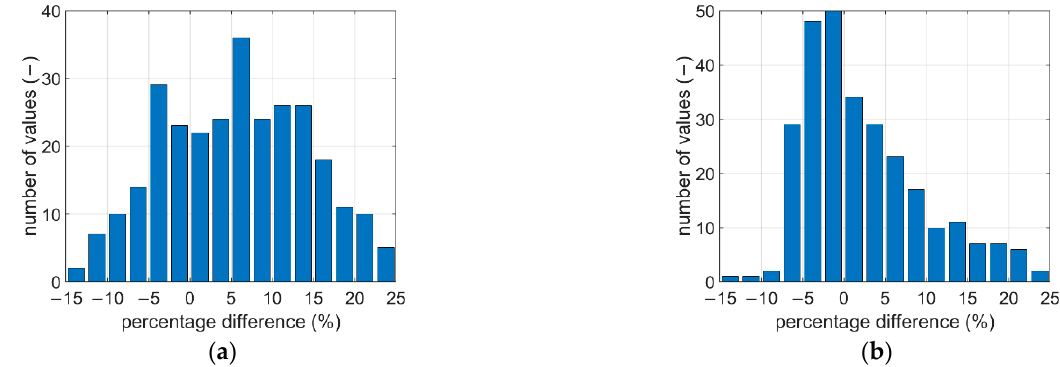
Table 6. Comparison of measured and analytically determined BCT values for various corrugated cardboard packaging.